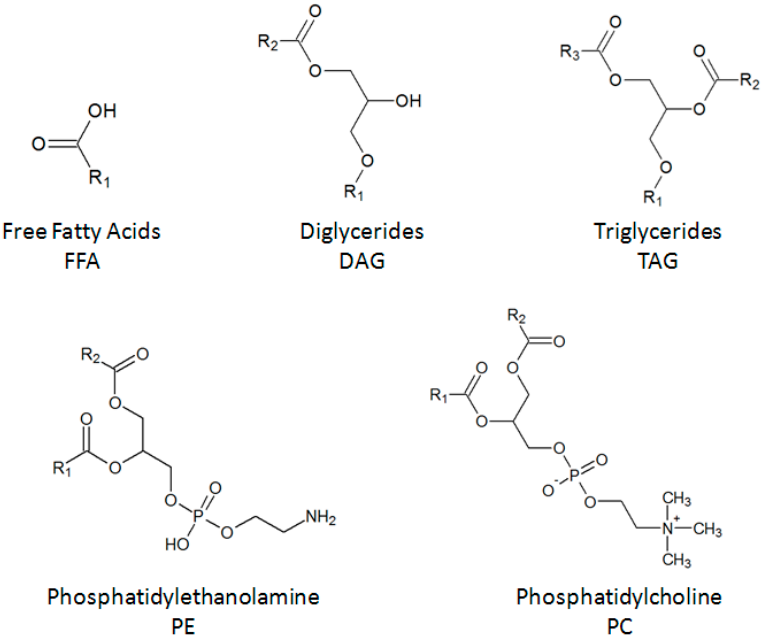
Figure 5. Structure of major lipids (FFA, DAG, TAG, PE, PC) found in yeast ( Yarrowia lipolytica ).